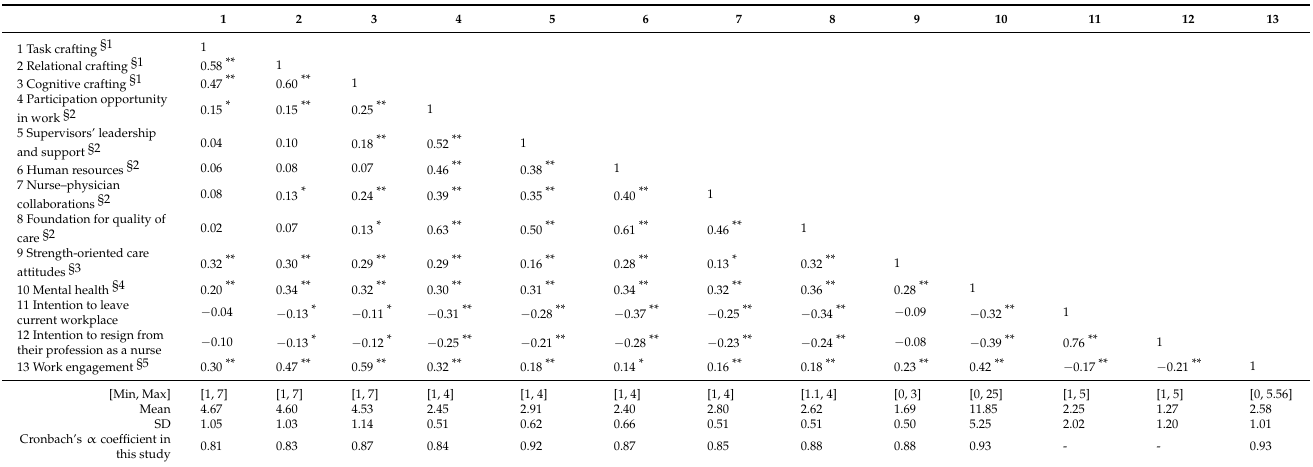
Table 2. Pearson’s correlations coefficients, means, and standard deviations of the variables in this study ( n = 309).